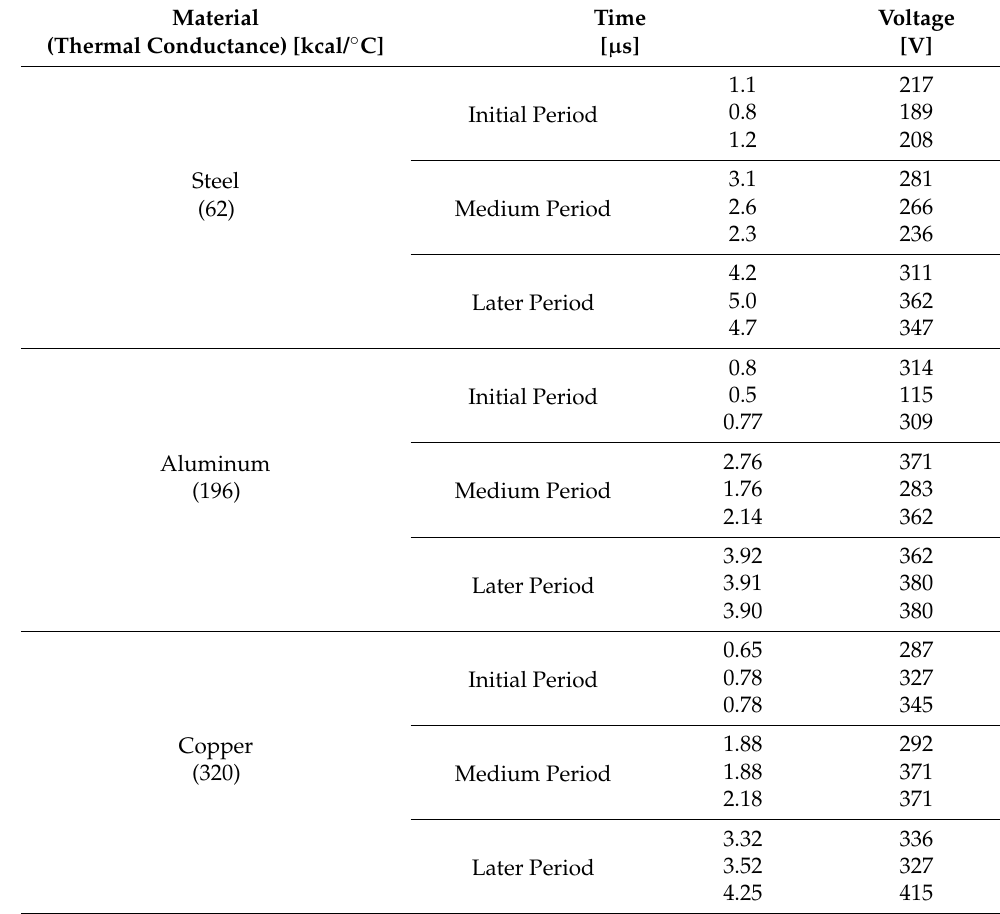
Table 1. Measurement result of DRV in previous paper